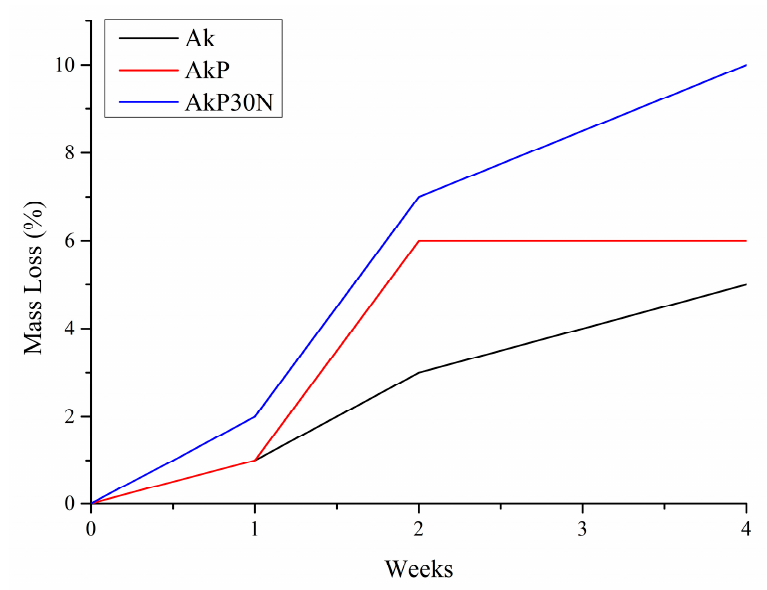
Figure 18. Results of in vitro degradation evaluation of the synthesized scaffolds. Table 8. Degradation rate (in %) of the synthesized scaffolds after 1, 2, and 4 weeks of incubation. Mass Loss (%) Ak AkP